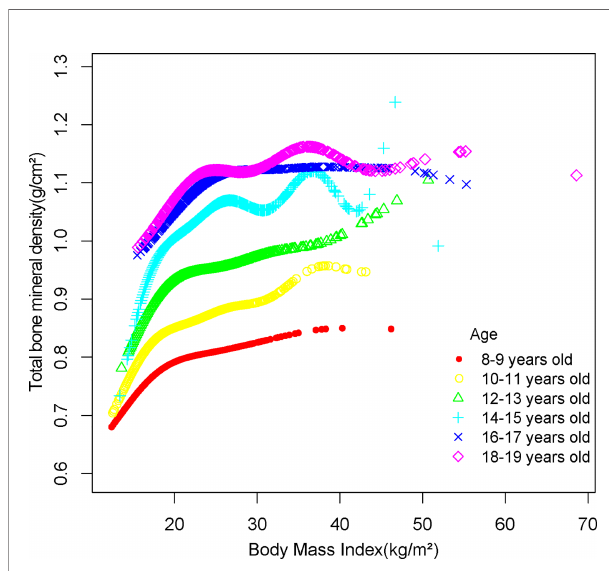
FIGURE 4 | The association between BMI and total bone mineral density strati fi ed by